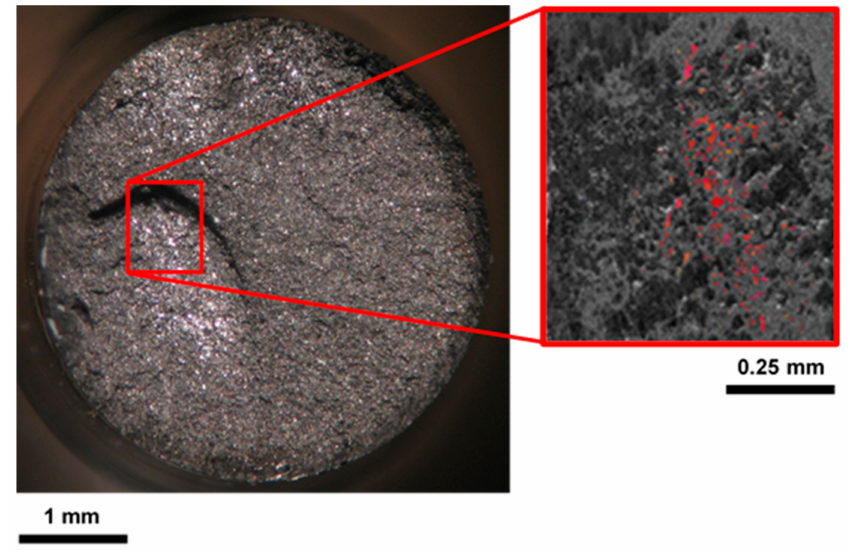
Figure 15. EBSD detection of facets exposed by fatigue failure, correlating to a macro-zone in Ti-834 disc